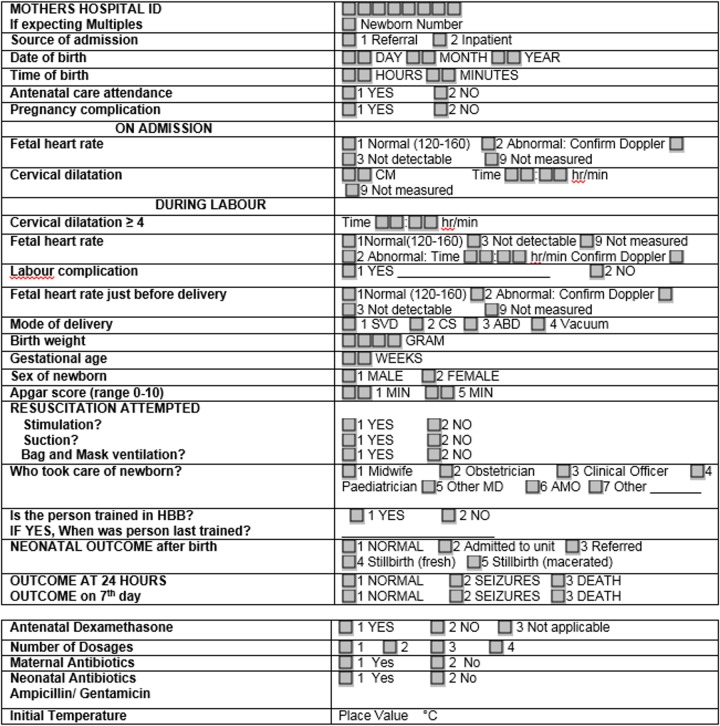
Data collection sheet.